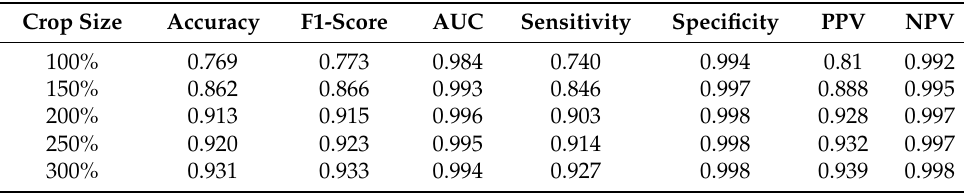
Table 1. Mean performance of the models on hold-out test set. Performances of train and validation set are reported in Tables 2 and 3. Crop Size